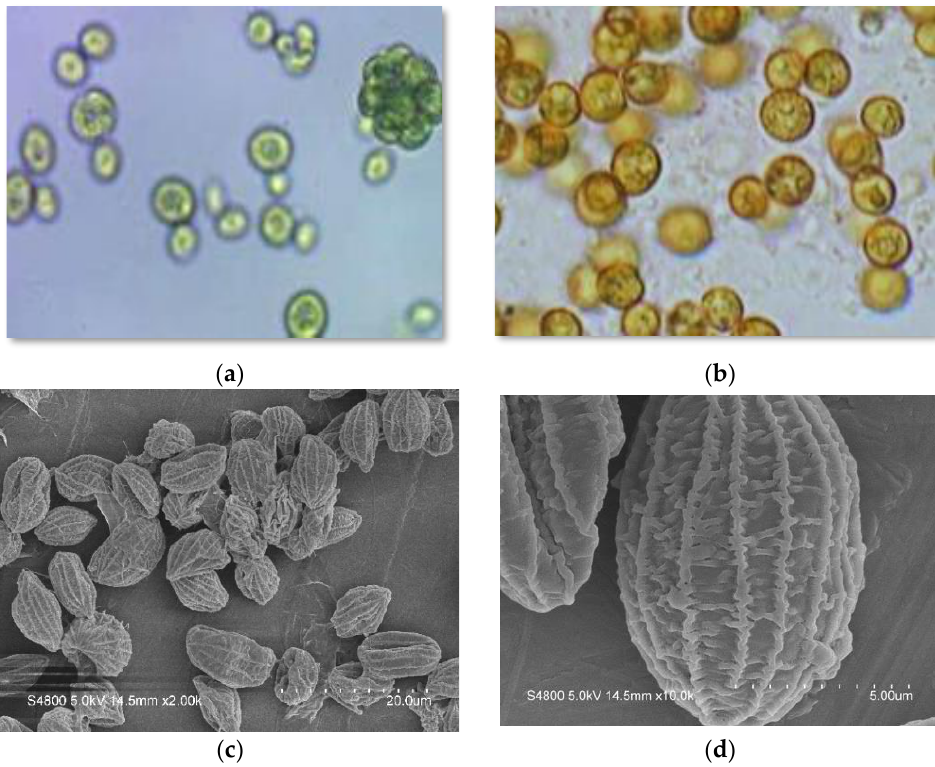
Figure 1. Micrographs of green and red Coelastrella cells obtained by optical and scanning electron microscopy: ( a ), ( c ), ( d ): “green” cells at end of exponential growth phase; ( b ): “red” cells after 12 days of stressing (see Figure 4 for details).